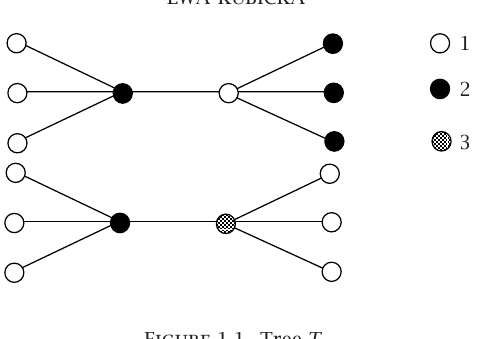
Figure 1.1 . Tree T